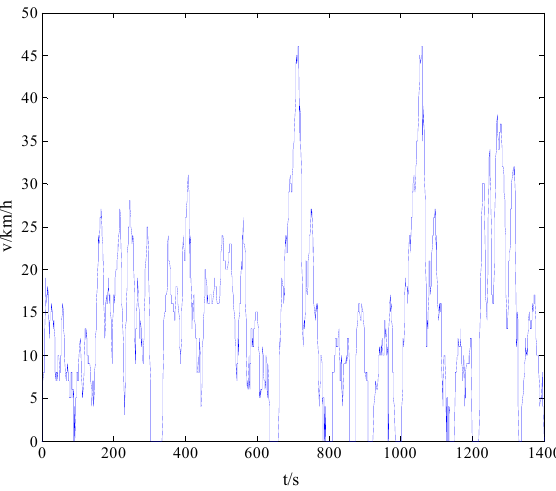
Figure 4. The China urban passenger driving cycle.